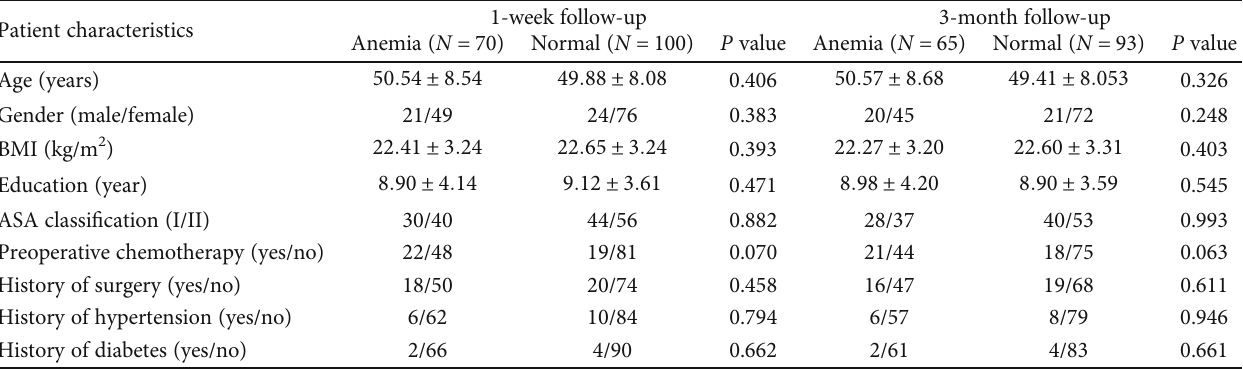
Table 1: Baseline, preoperative, and demographic characteristics of the two group patients.